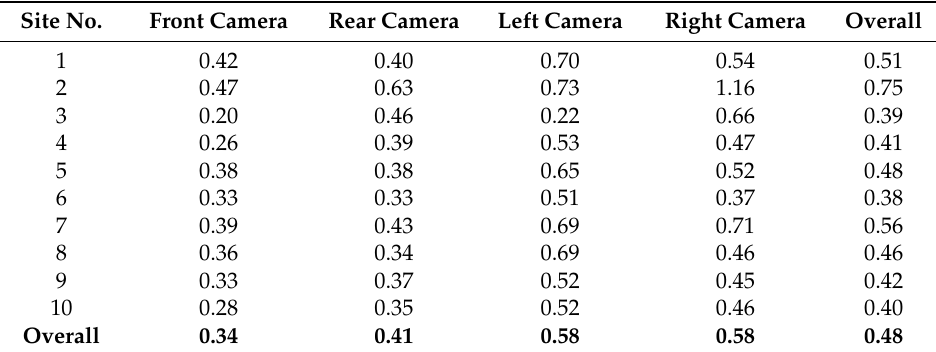
Table 1. Average Camera Angle Error without Parameter Co-Refinement